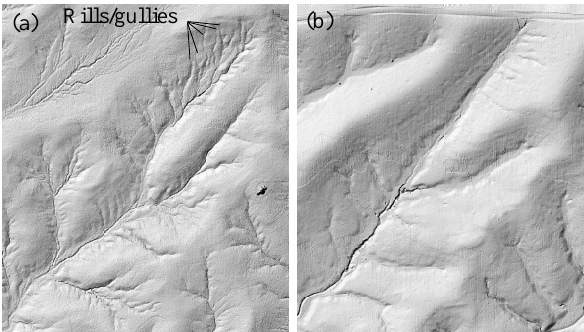
Figure 4. Detailed shaded relief images (locations shown in Fig. 3) illustrating the presence of parallel hillslope rills and gullies in the shrubland areas (shown in a ). Grassland areas (shown in b ) have fewer such features.